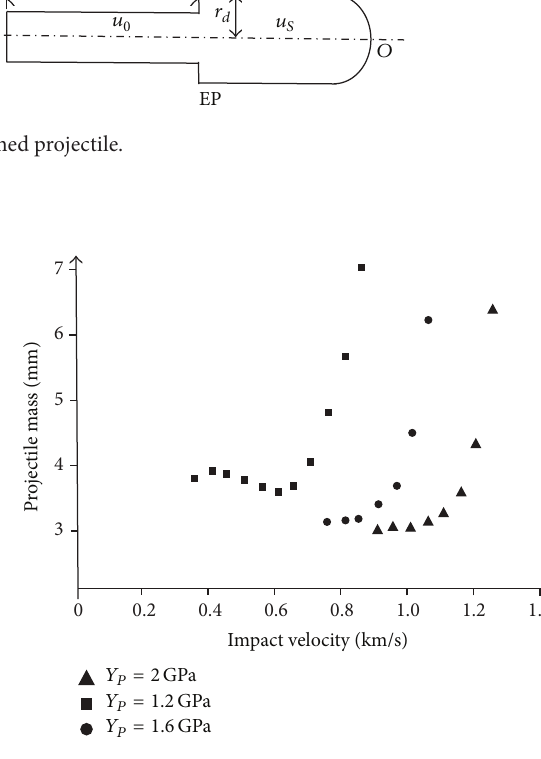
Figure 9: Numerical calculating results of Rosenberg and Dekel [78].